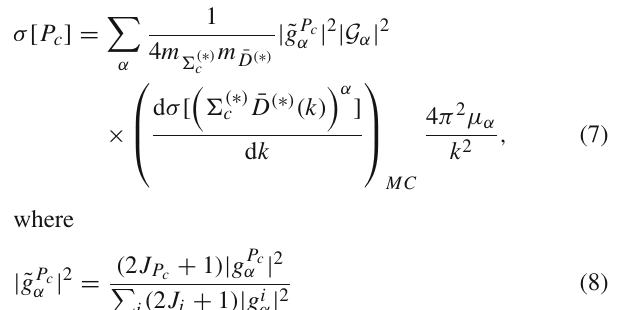
( ∗ ) ¯ D ( ∗ ) hadronic molecular picture. c ( ∗ ) ¯ D ( ∗ ) are denoted as “All” in c